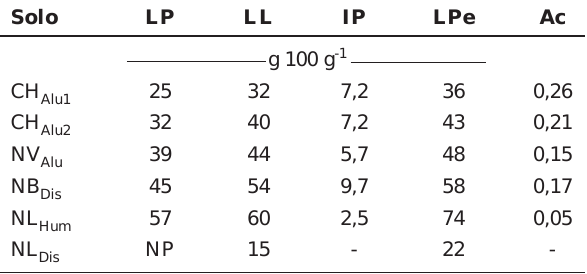
= Nitossolo Vermelho Alu = Neossolo Litólico Dis